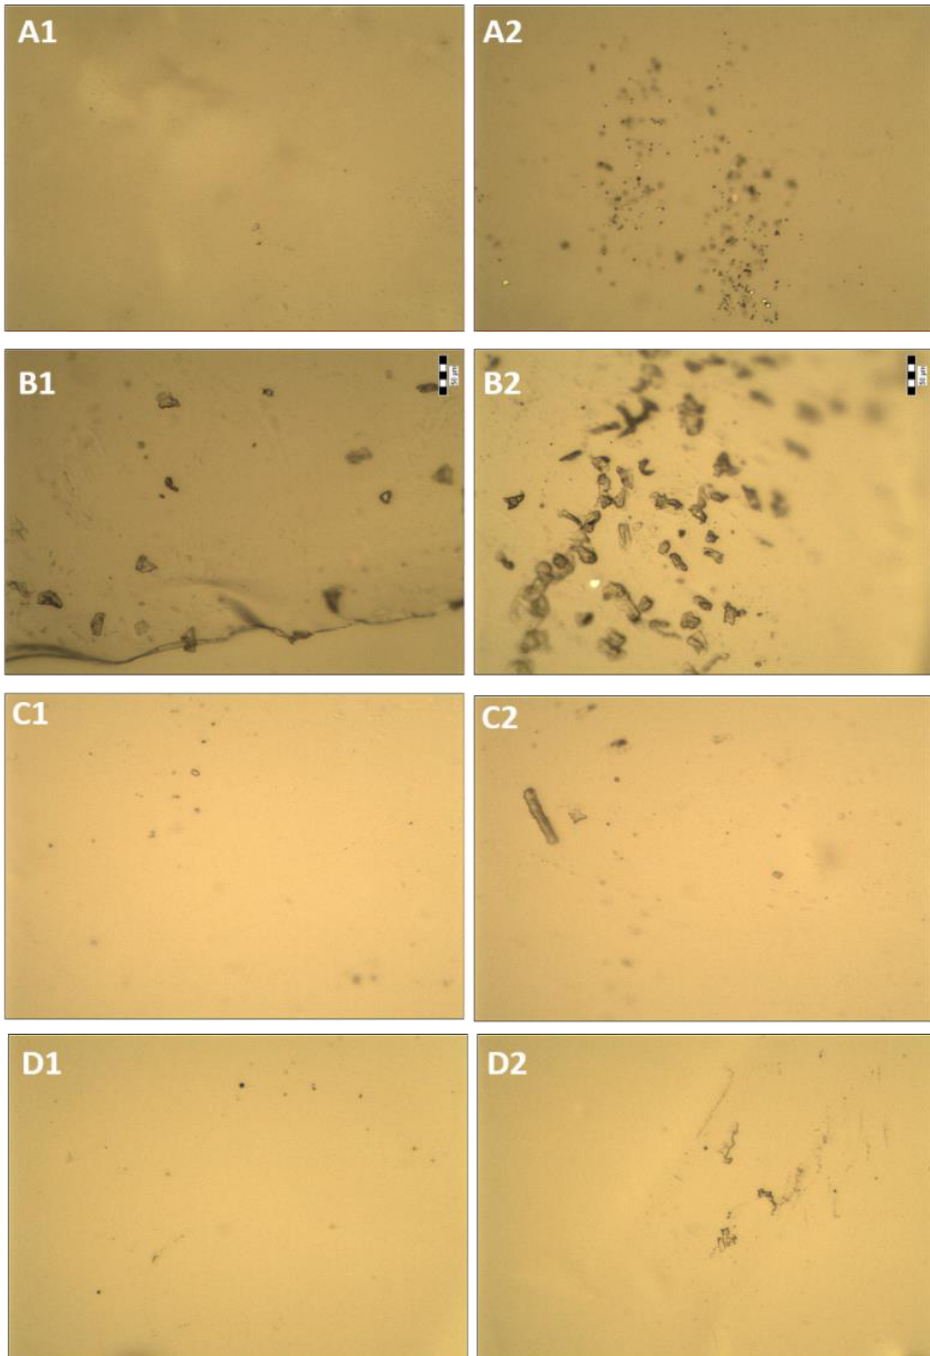
Figure 4. Optical images of unloaded films: ( A1 ) and ( A2 ) different surface sections of CS film; ( B1 ) and ( B2 ) different surface sections of HPMC film; ( C1 ) and ( C2 ) different surface sections of HPMC:CS = 1:1 film; ( D1 ) and ( D2 ) different surface sections of HPMC:CS = 2:1 film. The scale bar represents 50 μm.